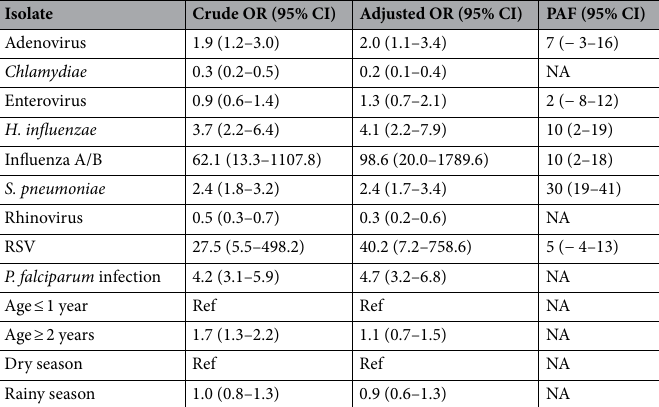
Table 2. Crude and adjusted ORs and PAF for associations between specific isolates and admission with symptoms of LRTI, estimated by logistic regression. OR, odds ratio; CI, confidence interval; PAF, population attributable fraction; RSV, Respiratory syncytial virus; NA, not